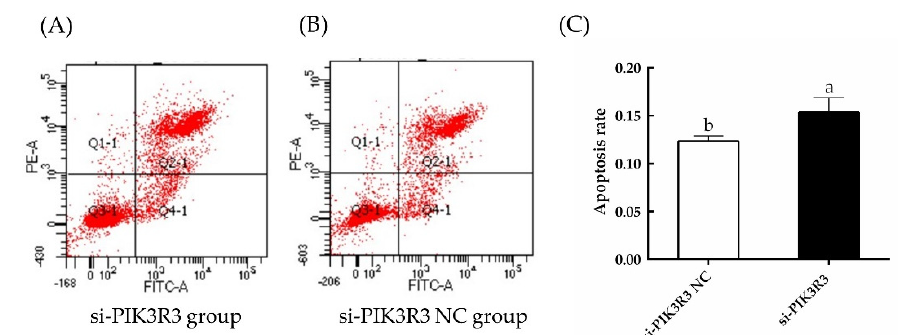
Figure 3. The effects of siRNA-mediated knockdown of PIK3R3 expression on apoptosis were monitored by flow cytometry. The rate of apoptosis was measured by annexin V − FITC and PI staining of cells transfected with si-PIK3R3 ( A ) and an si-PIKR3 NC construct ( B ). ( C ) Quantification of the flow cytometry results from panels ( A , B ). The different small letters (a, b) in the same graph indicate that the difference between groups is statistically significant ( p < 0.05).